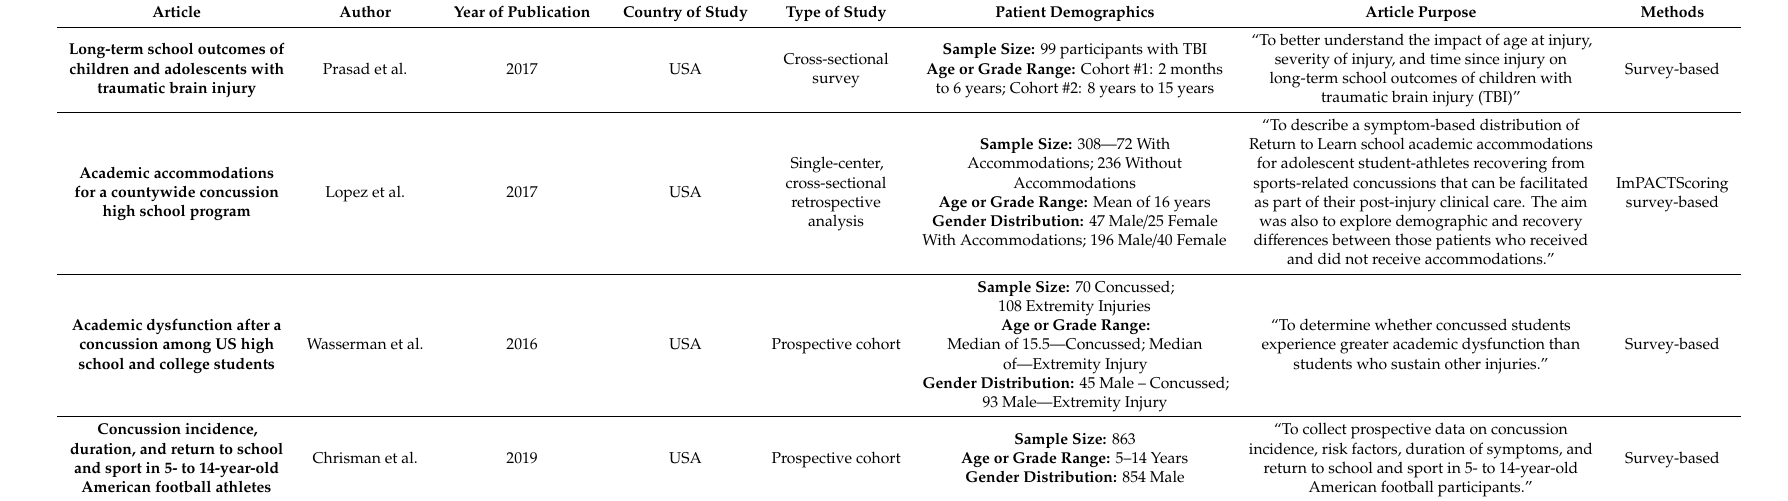
Table 2. Review of studies analyzing post-concussion academic dysfunction